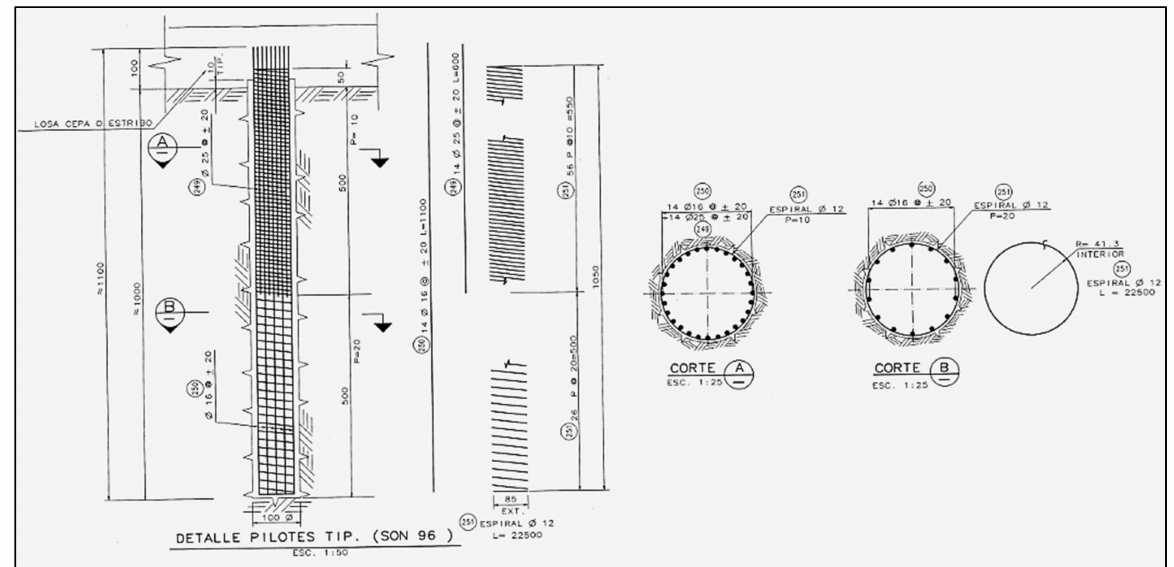
Figure 7. Original blueprint—the pile-type foundation of R í o Blanco bridge.